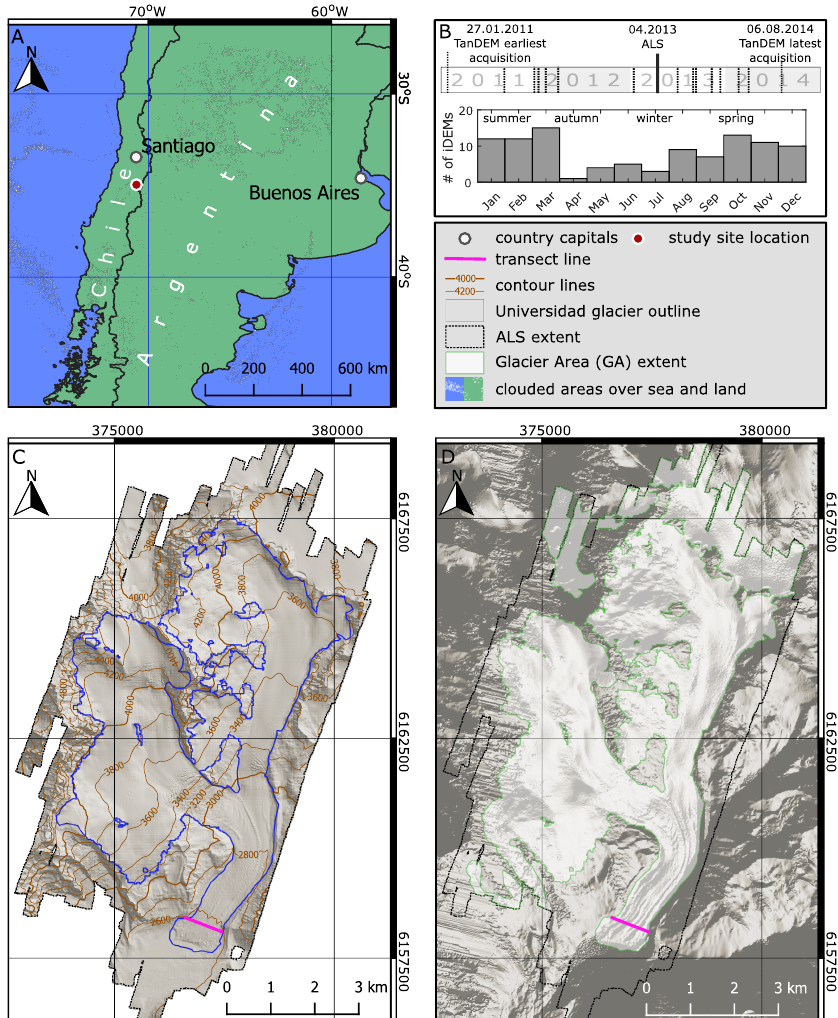
Figure 1. Spatial and temporal extent of the study. ( A )—study site location; ( B )—temporal distribution of SAR acquisitions used to build TanDEM. The acquisitions dates (dotted lines) were extracted from the DEM metadata. The solid line indicates the acquisition date of the ALS DEM used as reference. ( C )—Universidad Glacier topography, with hill-shaded ALS DEM used as basemap. The extent of GA is outlined in blue; ( D )—extent of all glacierized areas within the study area, with hill-shaded TanDEM DEM 12 m used as basemap. Areas falling outside the green outline and within the ALS DEM extent were considered stable area